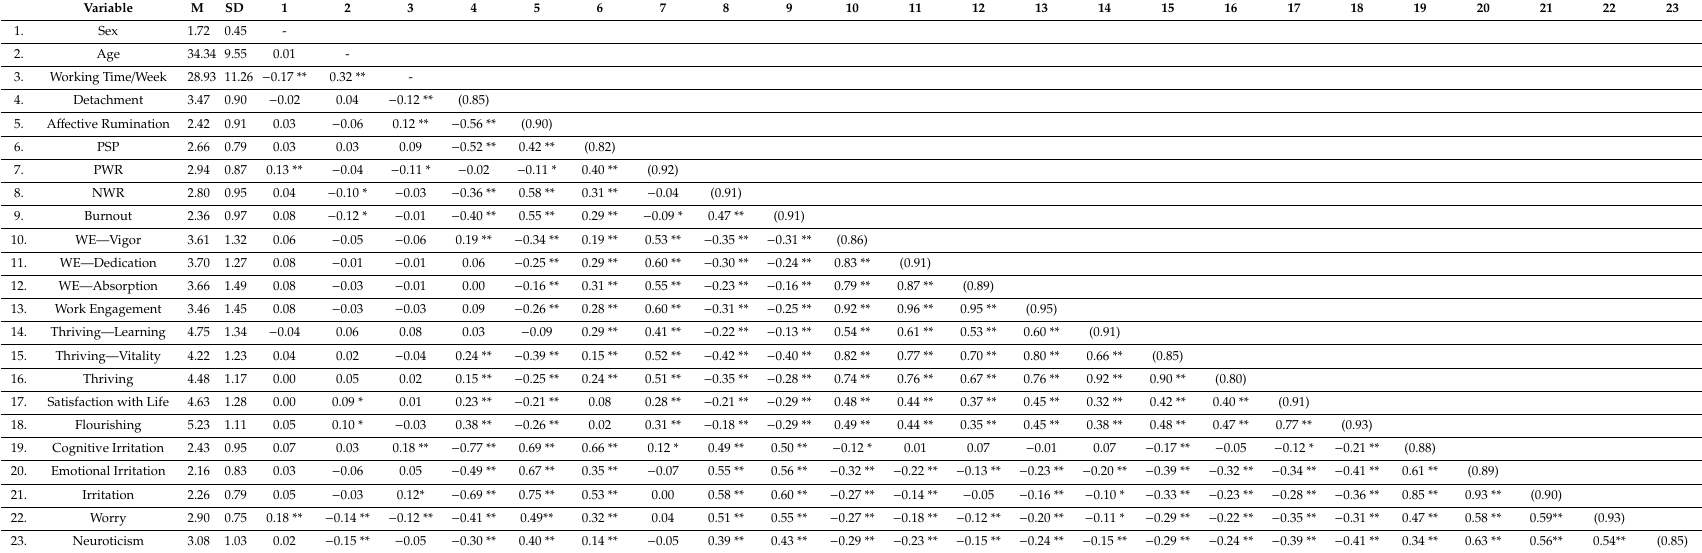
Table 1. Means, standard deviations, and zero-order correlations between study